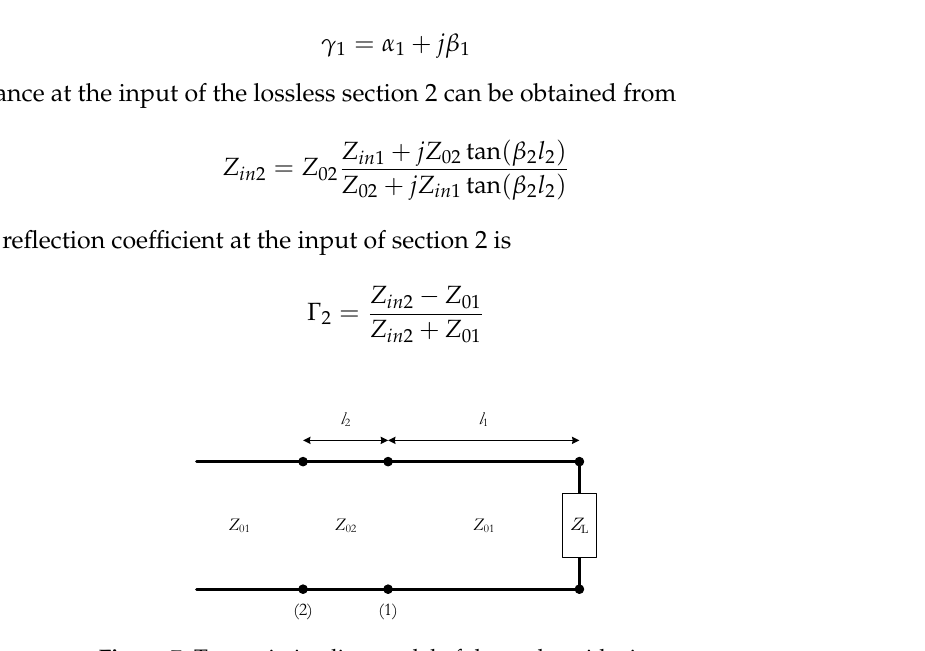
Figure 7. Transmission line model of the probe with air